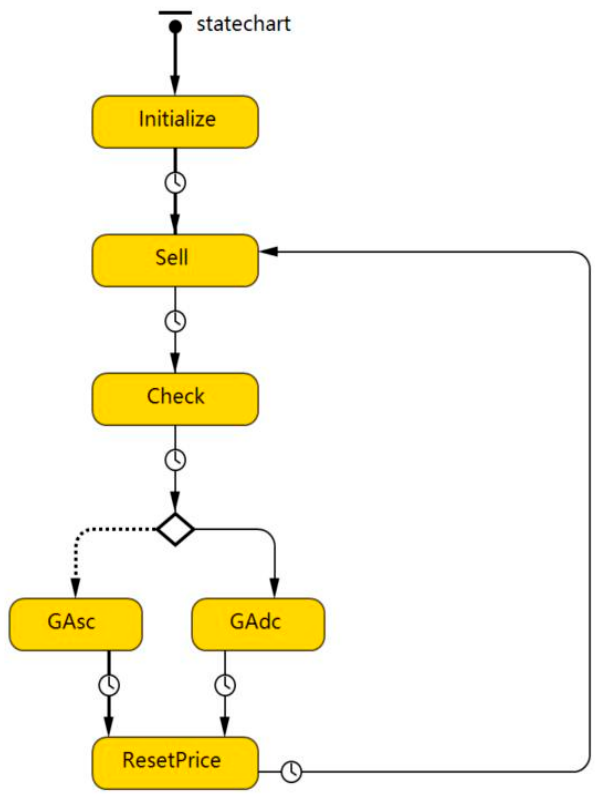
Figure 2. Agents’ actions in one period.